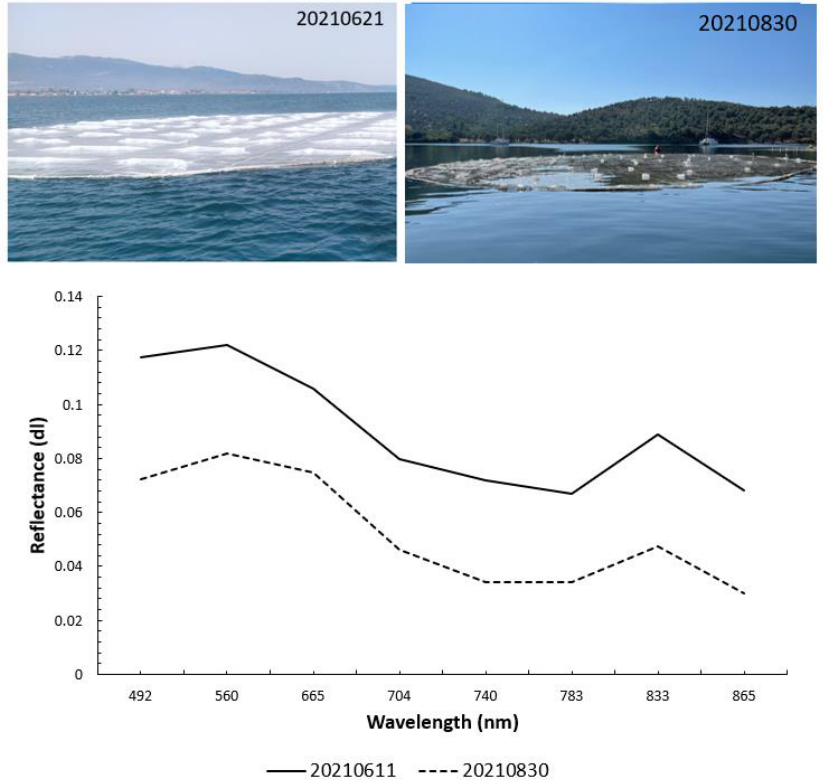
Figure 8. Top: Field images showing the target on the two different acquisitions; 20210611 floating on water surface, 20210830 partially submerged under a water column of about 20 to 30 cm. Bottom: Spectral plot of central pixel of HDPE mesh target floating on surface vs. partially submerged, no pixel averaging or background subtraction has been performed.